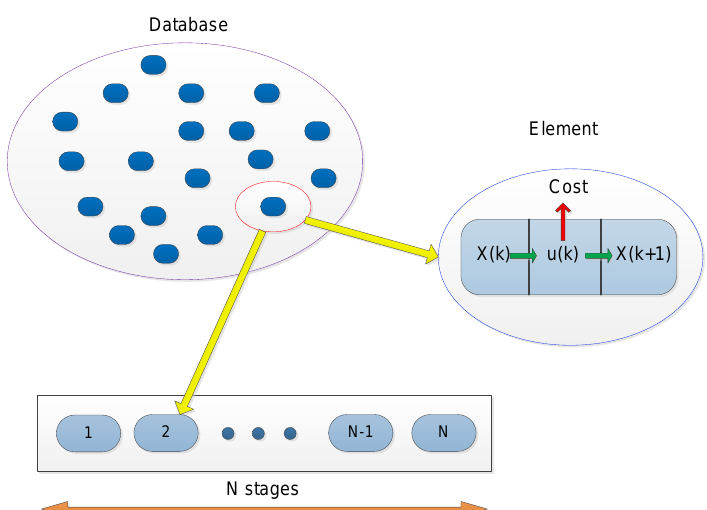
Figure 9. The operation process of the